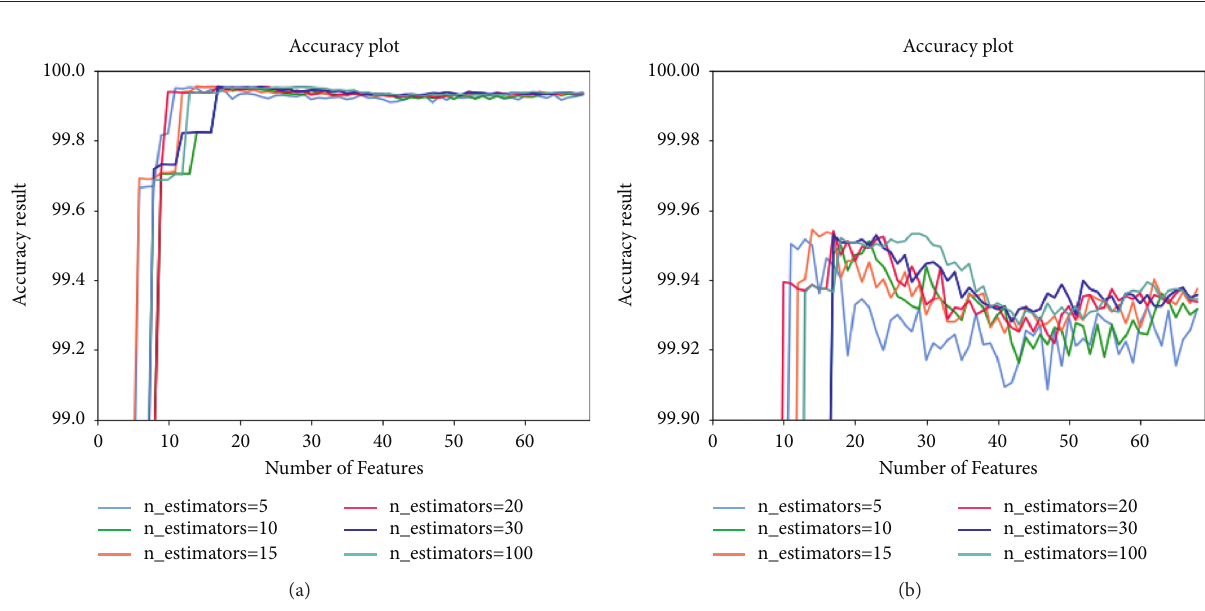
Figure 6: Accuracy score on CICIDS2017-Wed2 dataset with RFE. (a) Accuracy score above 99%. (b) Accuracy score above